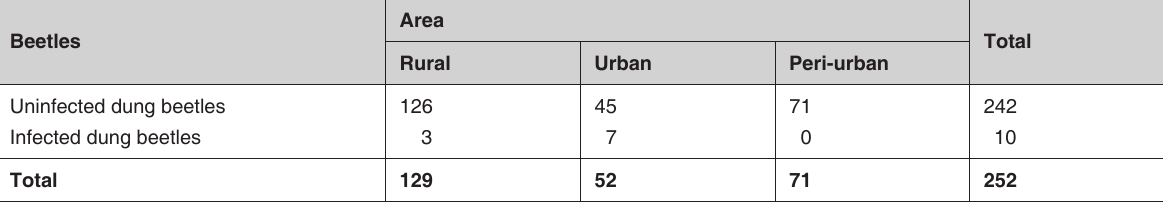
TABLE 4 Observed frequencies of uninfected and infected dung beetles from three areas in the Tshwane (Pretoria) Metropole